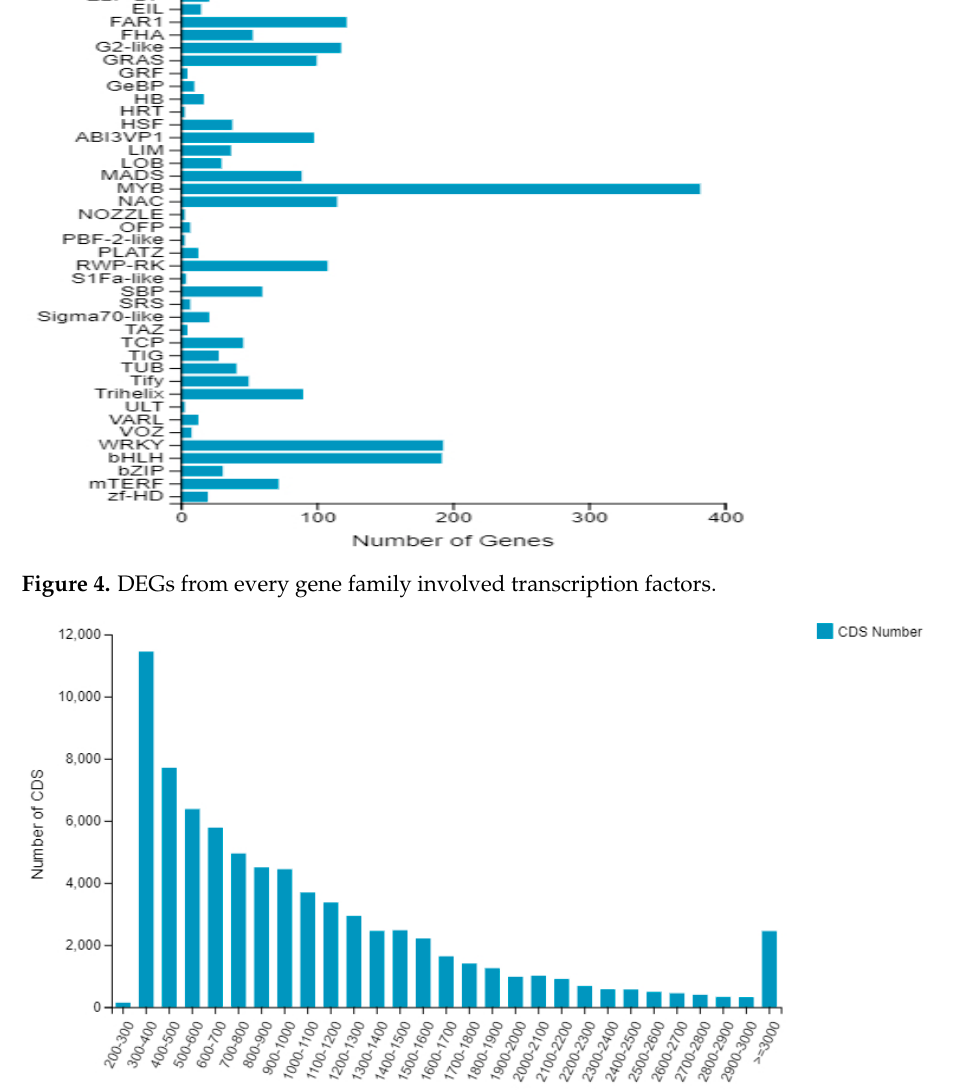
Figure 4. DEGs from every gene family involved transcription factors.